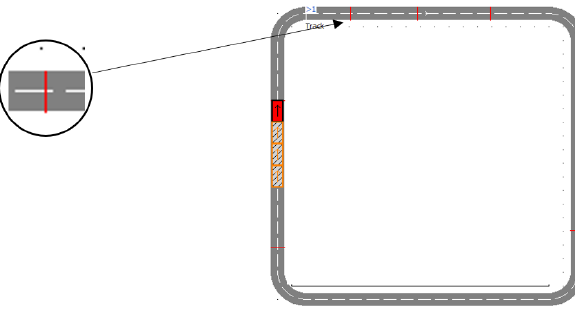
Figure 3: Route of the logistics train and its sensors for stopping.